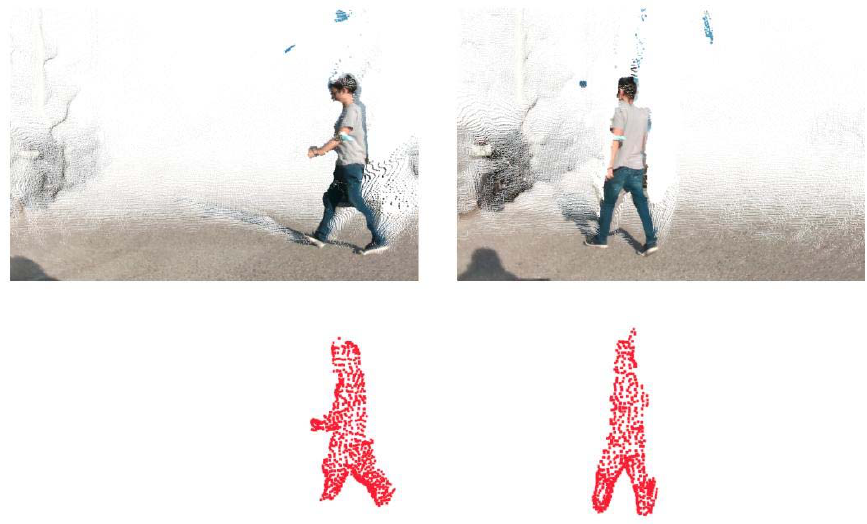
Figure 6. Moving obstacle detection (wandering pedestrian). In this test, both the person and the AGV were moving. ( Top ): original point clouds; ( Bottom ): detected clusters.